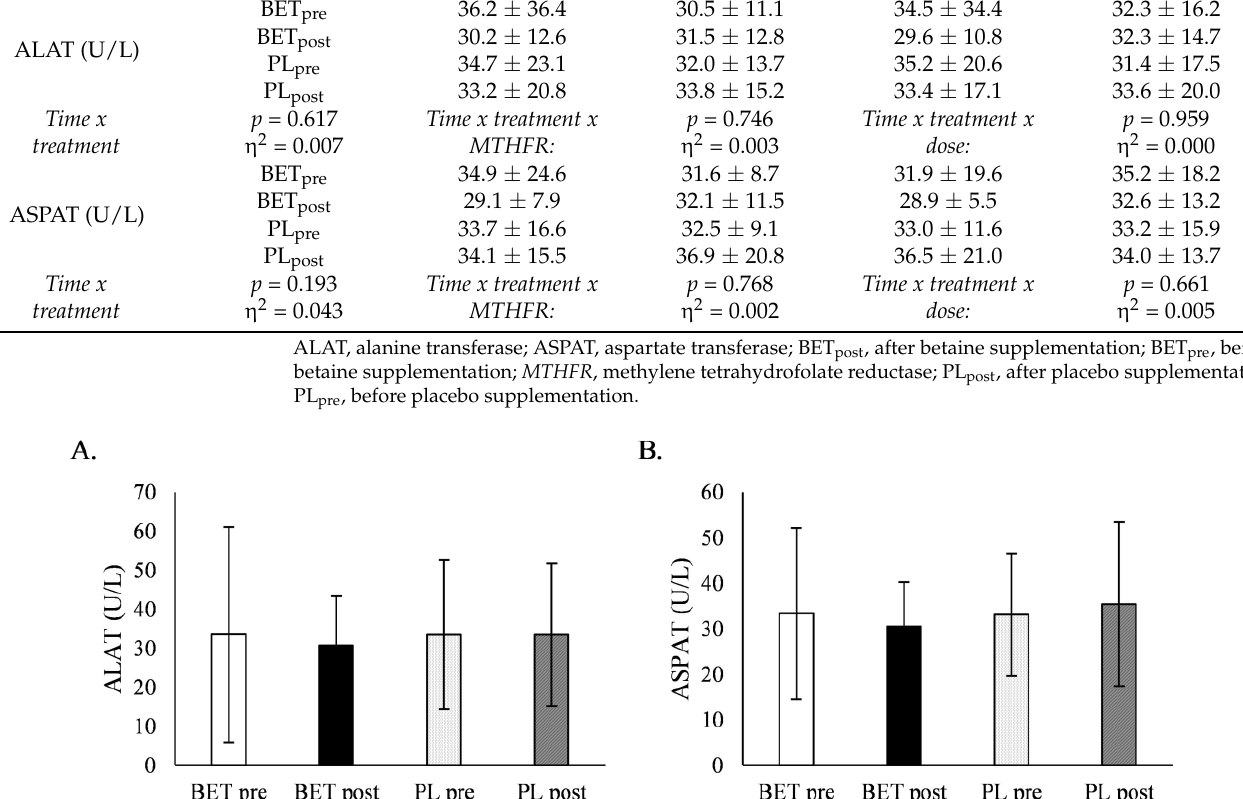
Figure 5. The effect of betaine supplementation on liver enzymes. ( A ). The effect of betaine supple- mentation on alanine transferase. ( B ). The effect of betaine supplementation on aspartate transferase. ALAT, alanine transferase; ASPAT, aspartate transferase; BET post , after betaine supplementation; BET pre , before betaine supplementation; PL post , after placebo supplementation; PL pre , before placebo